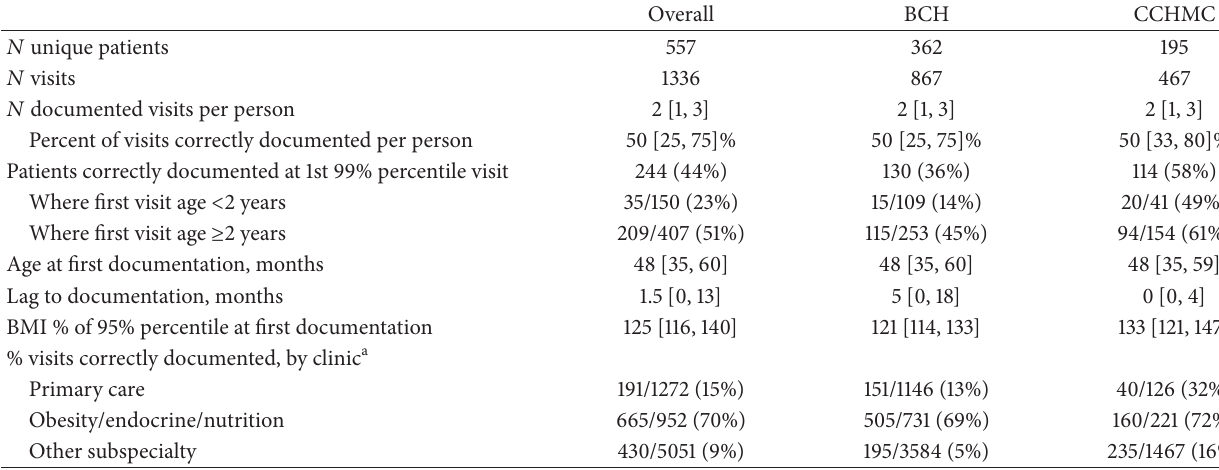
Table 5: Characteristics of documentation of